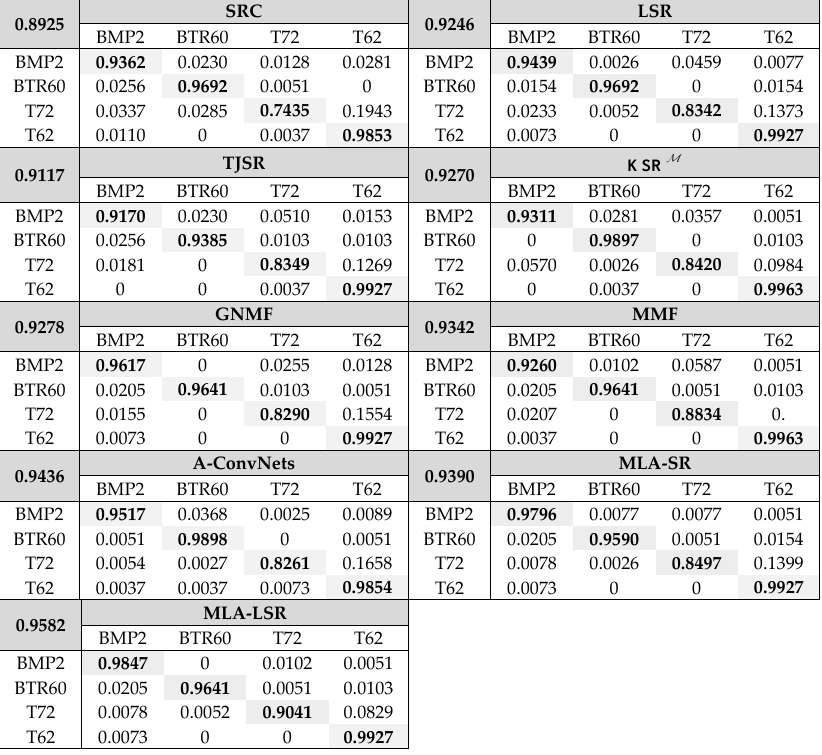
Figure 8. Confusion matrices by different methods. For each method, the average recognition accuracy is given on the top left corner of